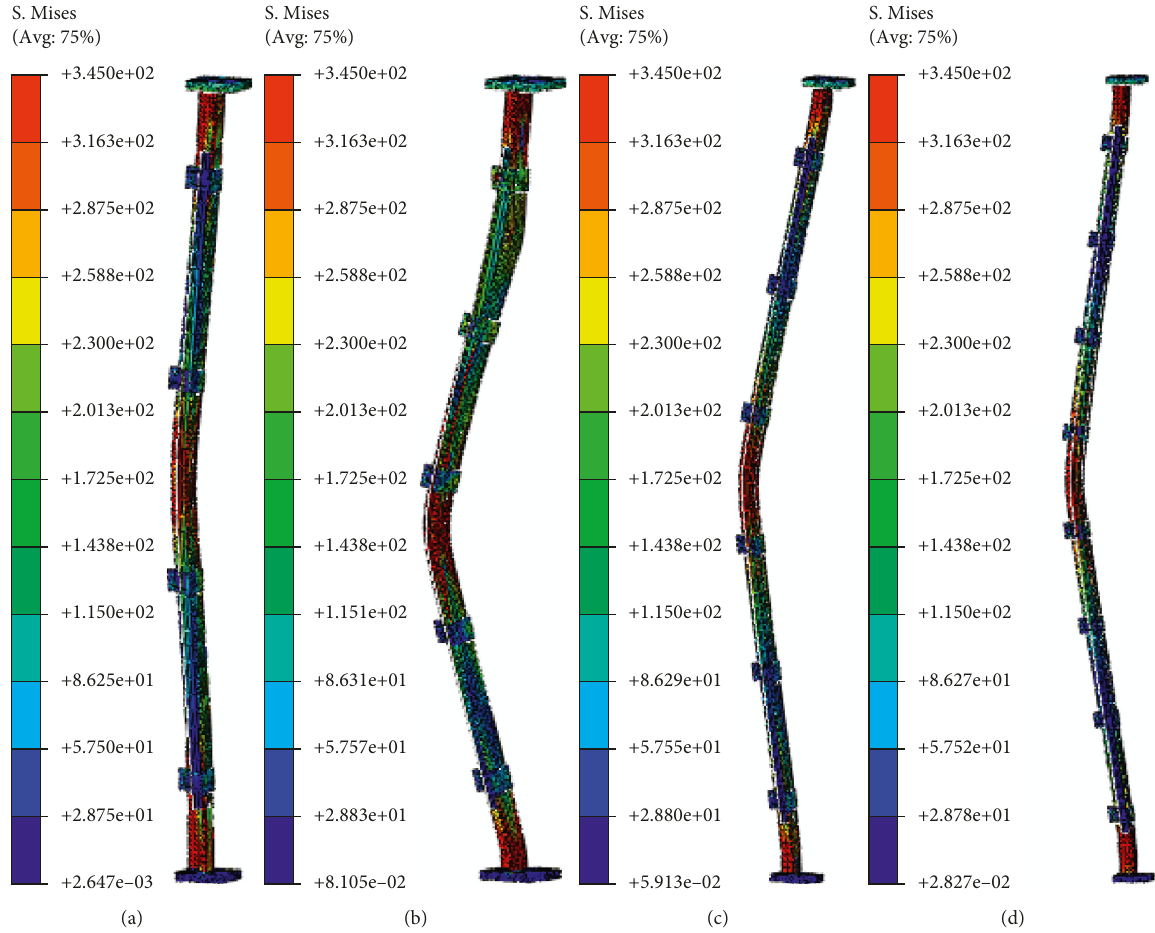
Figure 13: Buckling patterns of the members with different slenderness ratios. (a) L100 × 10G57SR55-575. (b) L100 × 10G57SR75-575. (c) L100 × 10G57SR95-575. (d) L100 × 10G57SR115-575.